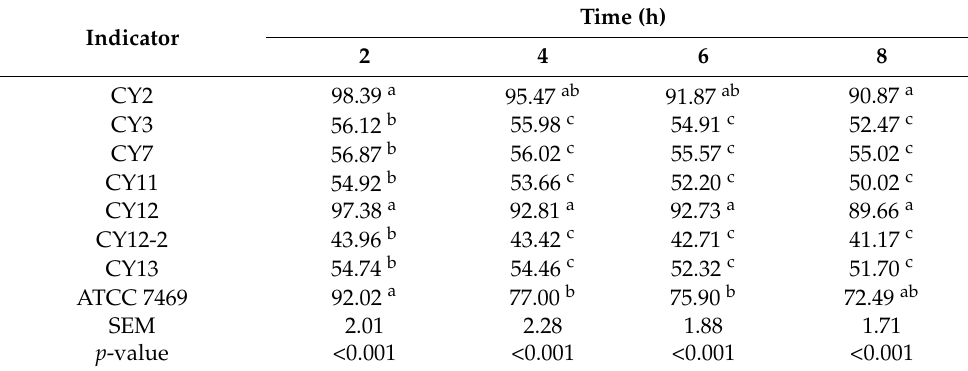
Table 5. Effect of simulated intestinal juice on the viability of Lactobacillus . Indicator